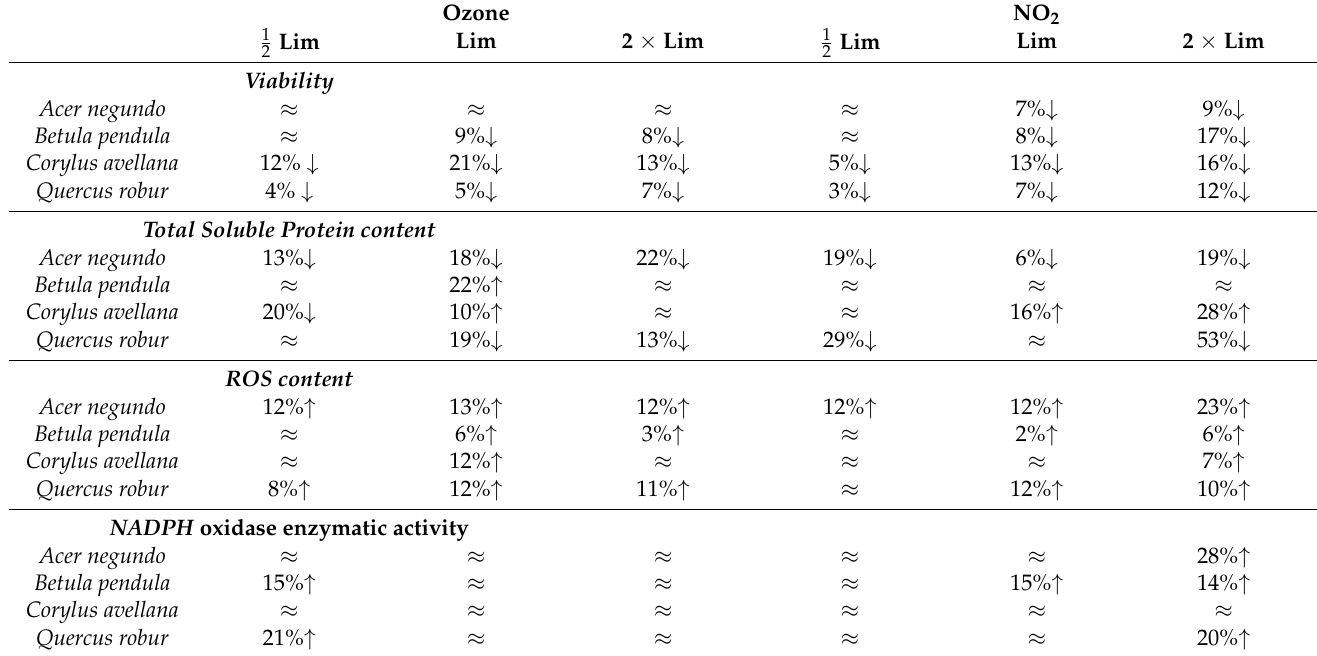
Table 2. Statistically significant percentage loss (arrows down) or increase (arrows up) in average pollen viability, total soluble protein content, reactive oxygen species (ROS) content and NADPH oxidase enzymatic activity, for A. negundo , B. pendula , C. avellana and Q. robur non exposed pollen, blank sample (B) and exposed for 6 h to O 3 and NO 2 at concentrations corresponding to values close to the half the limit (1/2), the limit (Lim) and the double limit (2 × Lim) for the protection of vegetation according to the EU Directive 2008/50/EC on ambient air quality and cleaner air for Europe. Statistically significant differences given by the ANOVA test followed by the Tukey’s post-hoc test ( p <